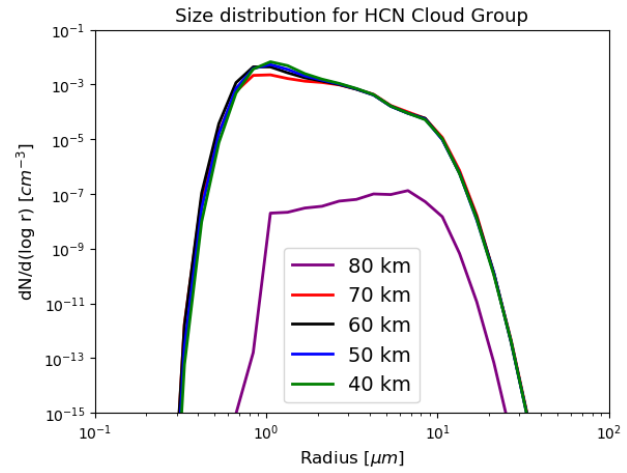
Figure 3. Size distribution of HCN particles in Titan’s